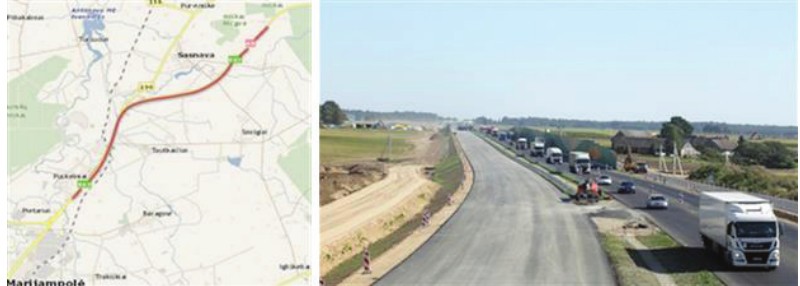
Figure 1. Location of testing sites 1–3, Kaunas–Marijampolė–Suvalkai